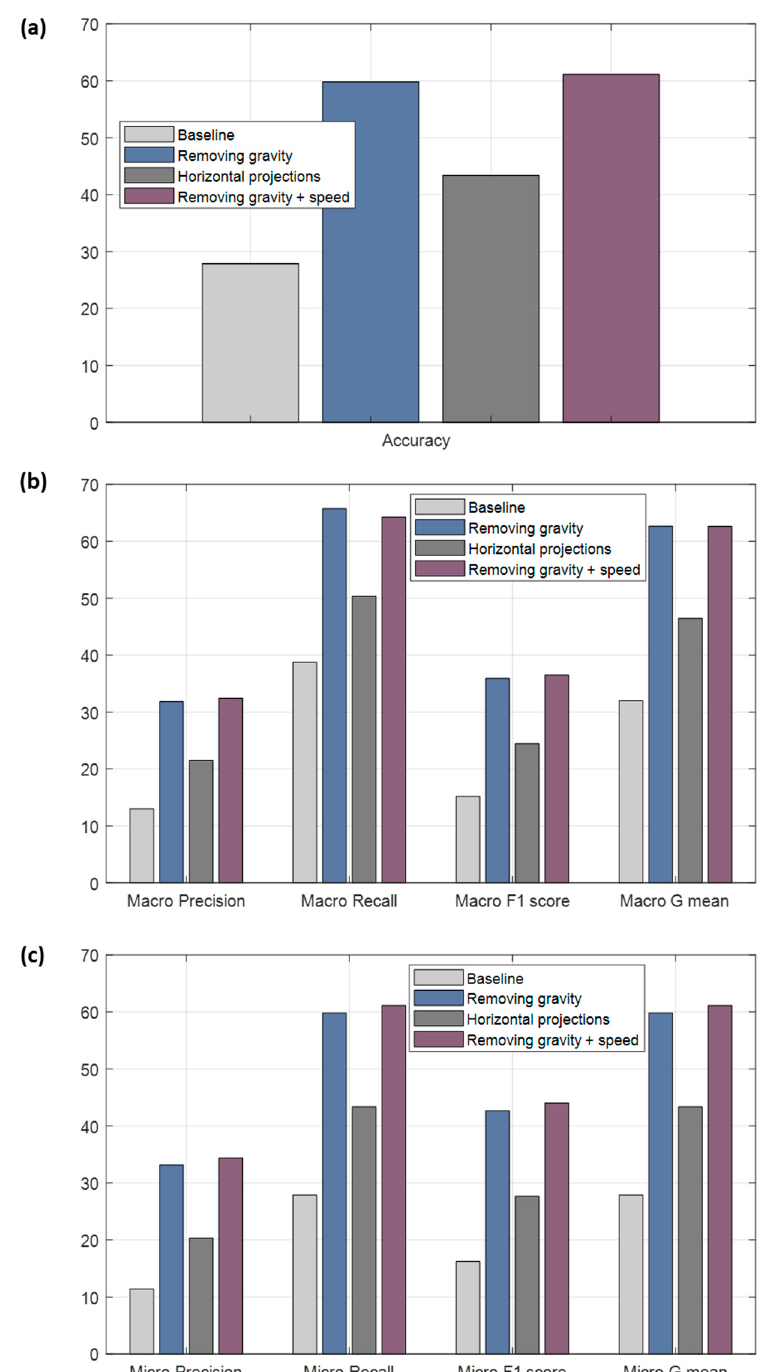
Figure 11. Performance metrics for maneuvers classification. ( a ) Accuracy. ( b ) Macro-averaged metrics. ( c ) Micro-averaged metrics. Table 6. Comparison of performances in VMD estimation when we require 60 or more samples.